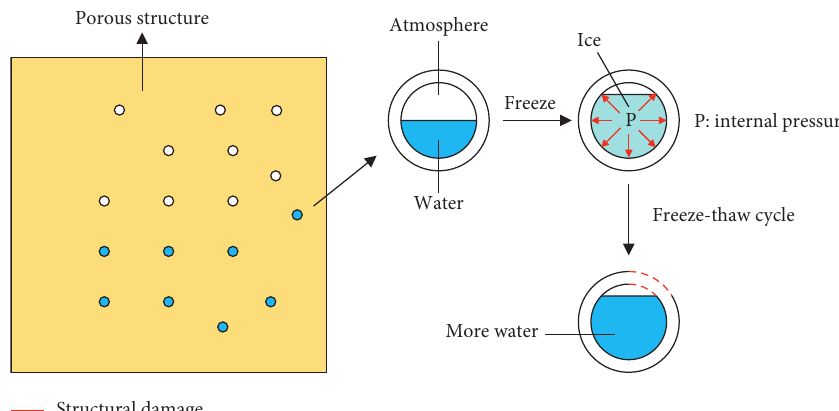
Figure 13: Deterioration mechanism of the thermal insulation material under the freeze-thaw